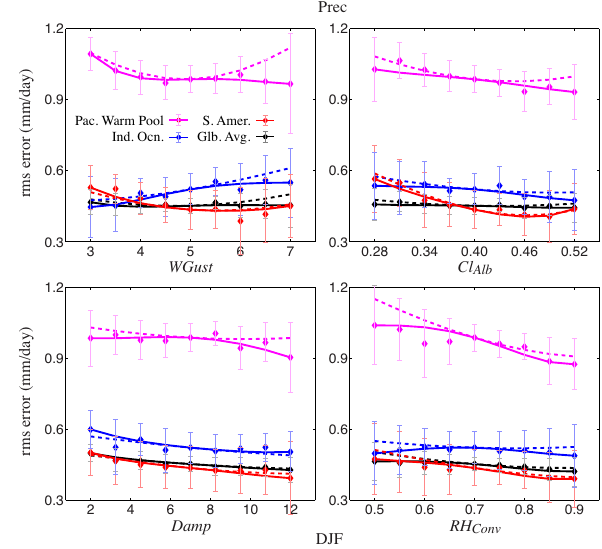
Fig. 8. Root-mean-square error of the AGCM precipitation clima- tology in December–February for target regions relative to the CPC Merged Analysis of Precipitation data set. The AGCM values are compared to the quadratic metamodel reconstruction based on the endpoints for each parameter, and to its linear counterpart. Global average in black, Pacific Warm Pool in magenta, Indian Ocean basin in blue and South America in red. Units on abscissa are ms − 1 for WGust, days for Damp and nondimensional for Cl Alb and RH Conv . Error bars quantify the spread of the RMS error within the ten en- semble members ( ± 1 standard error of the ensemble).